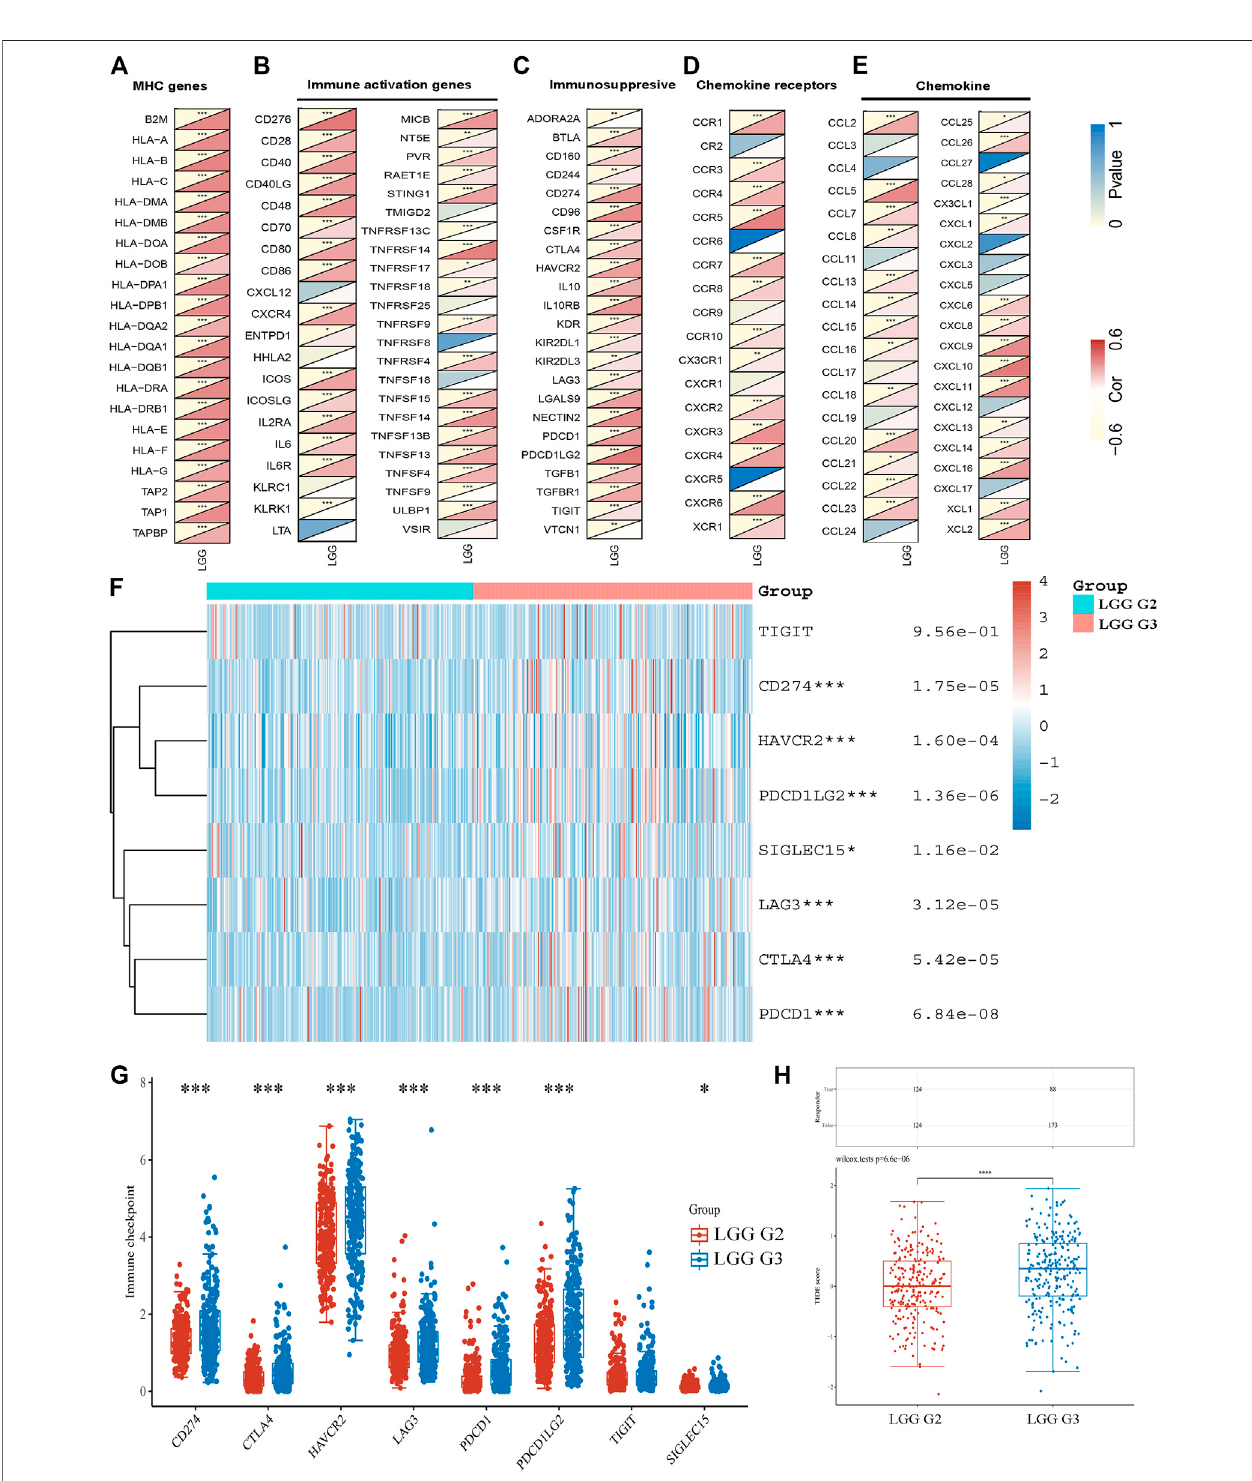
FIGURE 5 | The co-expression of TUBA1C with immune-related genes and the expression of immune-checkpoints in LGG. Co-expression of TUBA1C with MHC genes (A) , immune activation genes (B) , immunosuppresive genes (C) , chemokine receptors related genes (D) , and chemokine related genes (E) . (F , G) Different expressions of immune-checkpoints in grade II and III of LGG. (H) Different responses to immune checkpoint blockade in grade II and III of LGG.